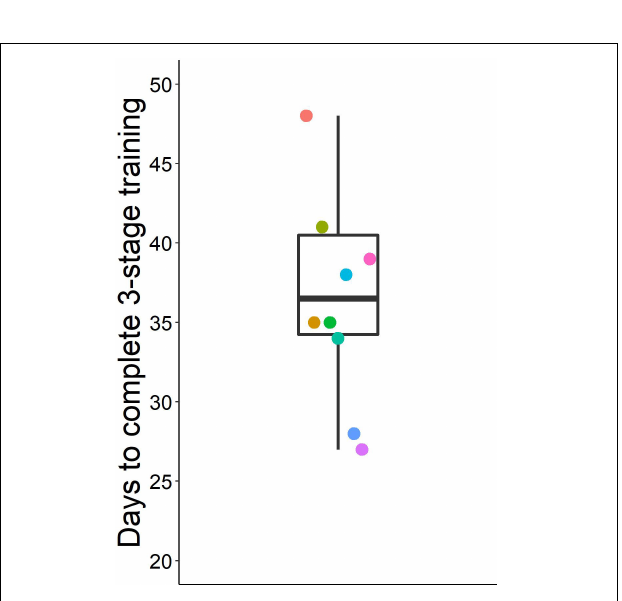
FIGURE 4 | Days to complete three training stages before starting probe sessions. Box plot shows median, 1st and 3rd quartile, and whiskers the 1.5 interquartile range. Data from n = 10 mice, a data point at 76 days is not